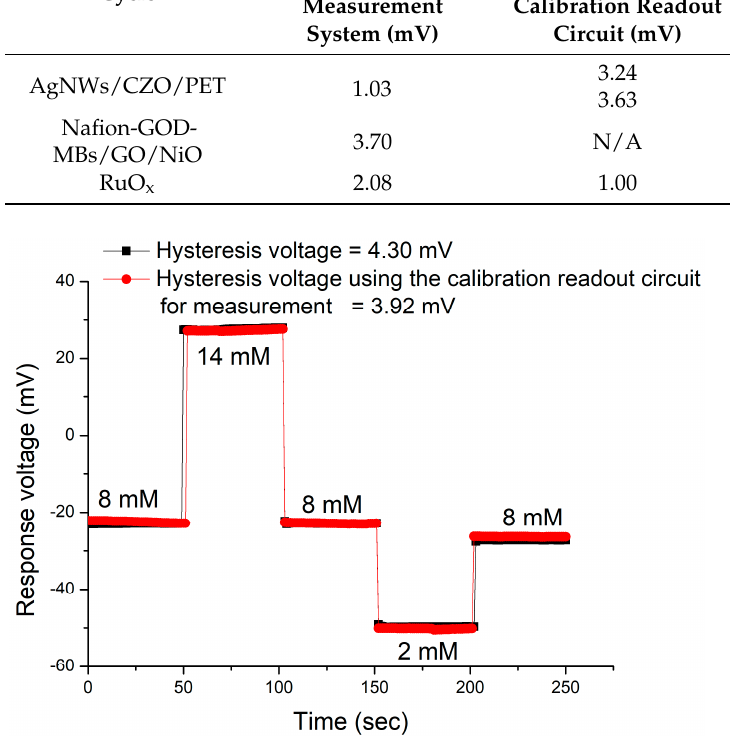
Figure 12. Hysteresis voltages of the CZO sensor by using the V-T measurement system and calibration readout circuit in the forward